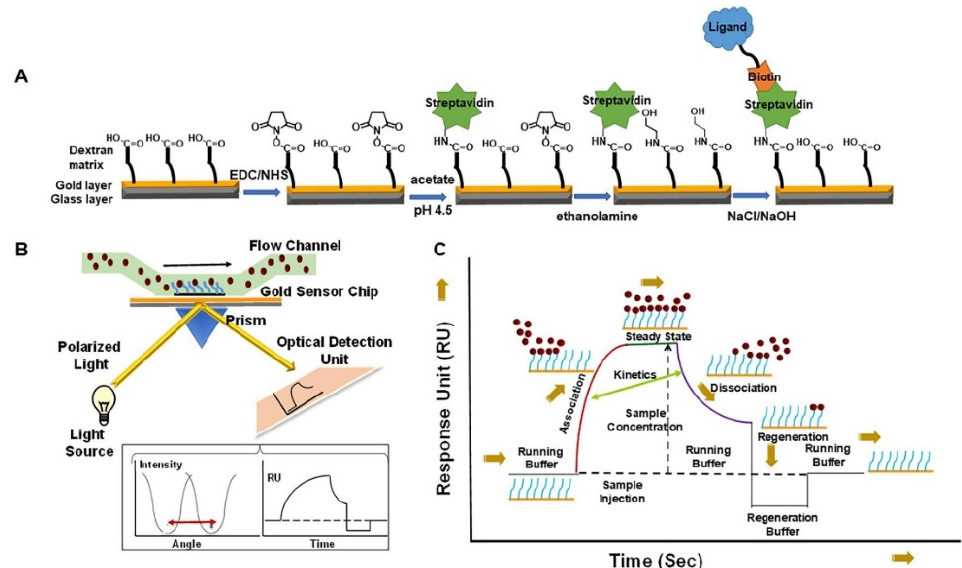
Figure 16. Schematic representation of ( A ) immobilization of biotin labelled RNA G4 on CM5 chip, ( B ) biomolecular recognition in the flow cell with changes in the angle of incidence light and ( C ) SPR sensorgrams. Reprinted with permission from ref. [173] Copyright 2019 Elsevier.